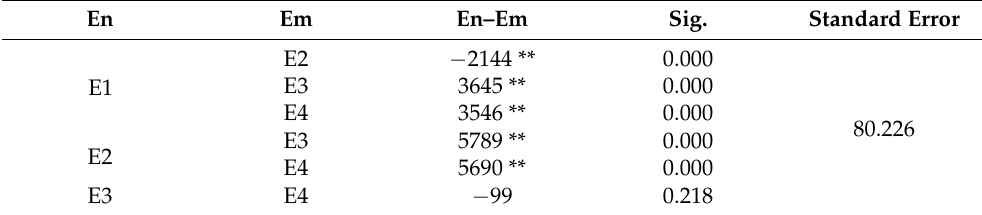
Table 7. Differences in mean yield (kg/ha) over the year–location interactions. En Em En–Em